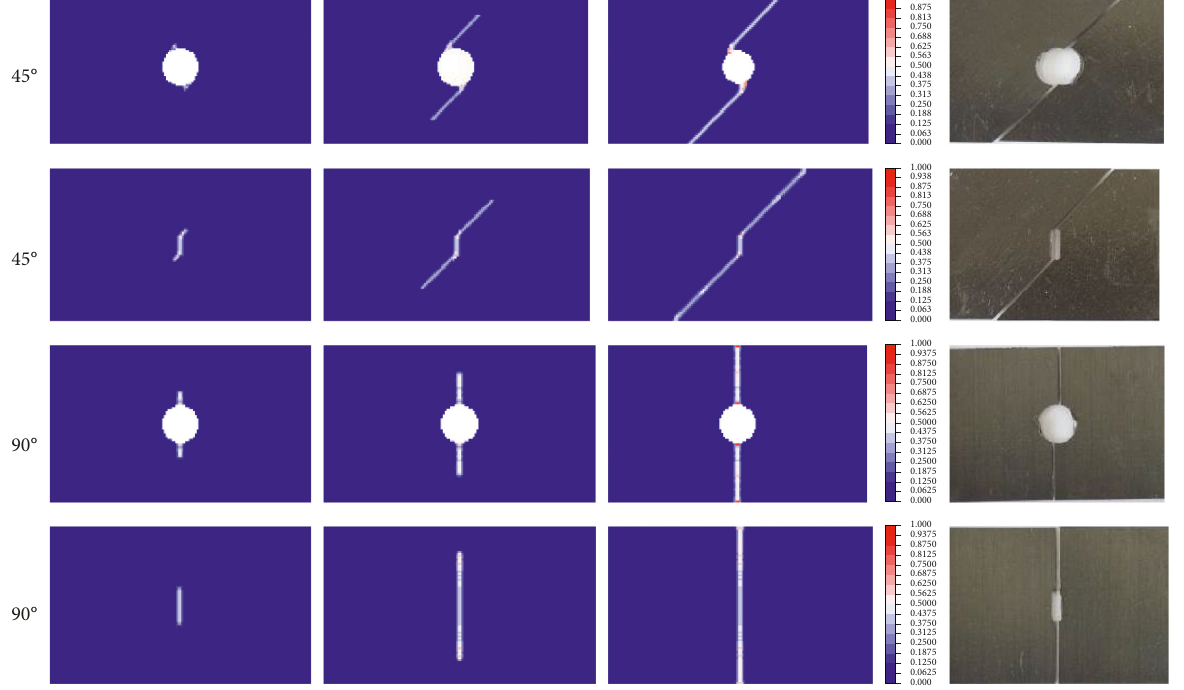
45 ° and α 90 ° (damage (cid:27) (cid:27)